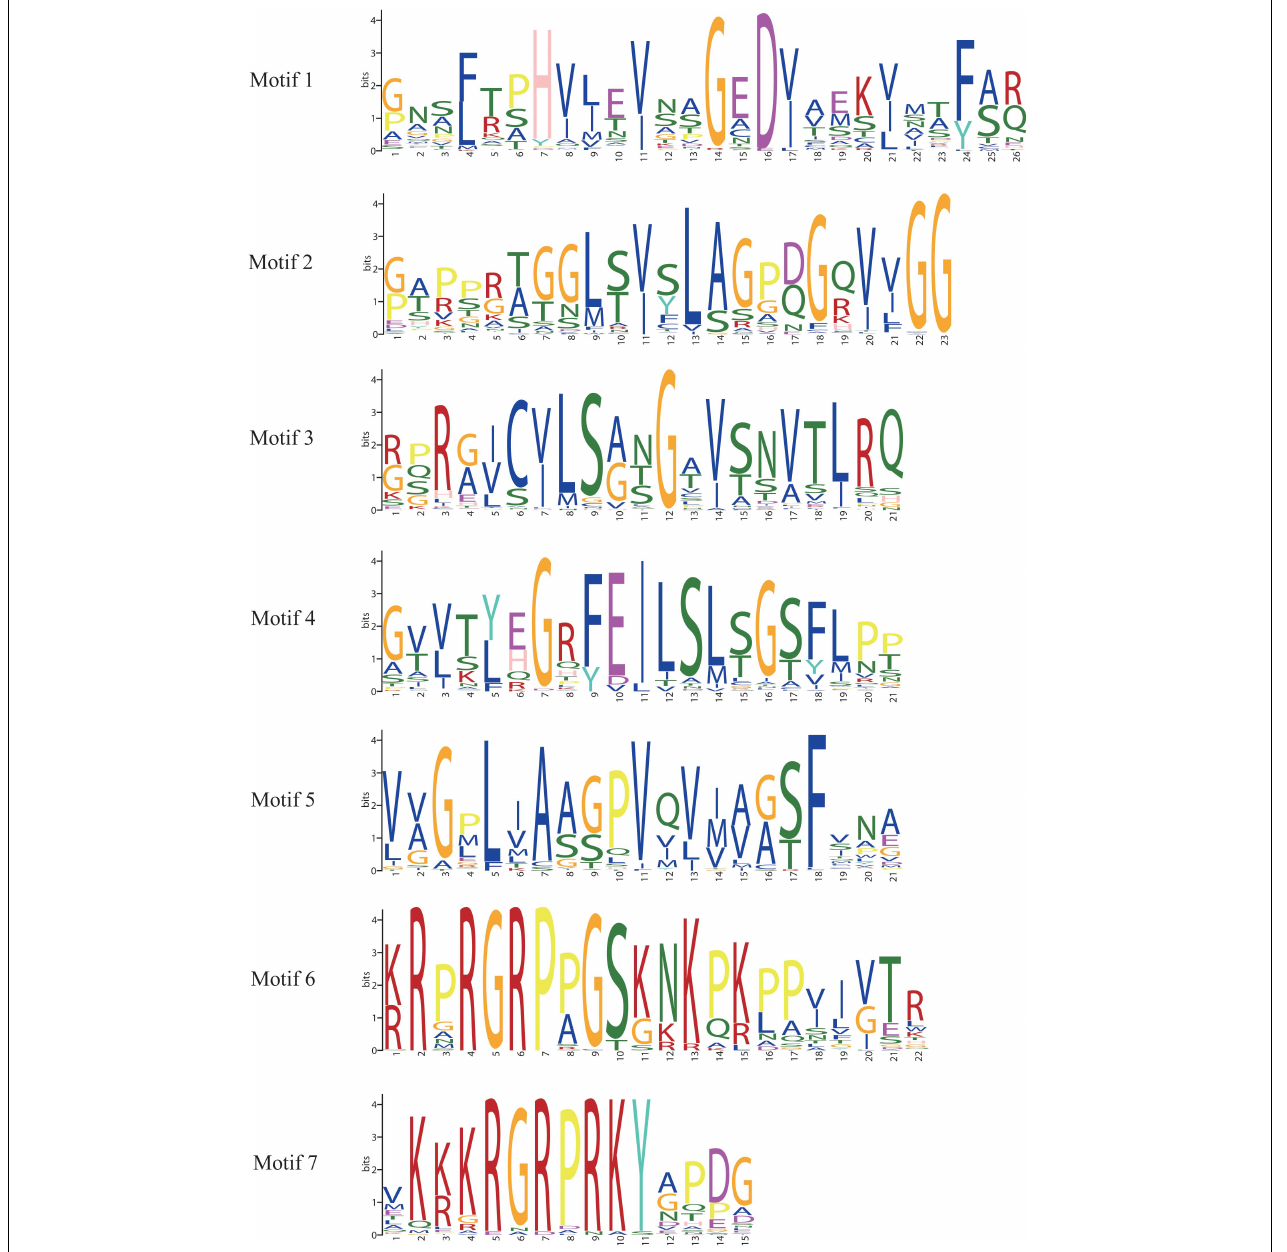
FIGURE 2 | Sequence logos of conserved motifs in BnaAHLs . The logo indicates the sequence of seven motifs. A letter represents an amino acid, and the size represents its conservation at this position.